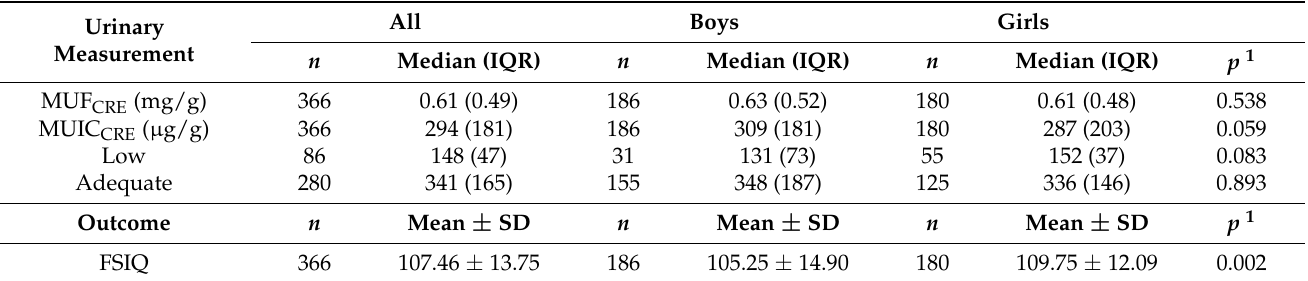
Table 2. MUF CRE , MUIC CRE , and Full-Scale IQ by sex.